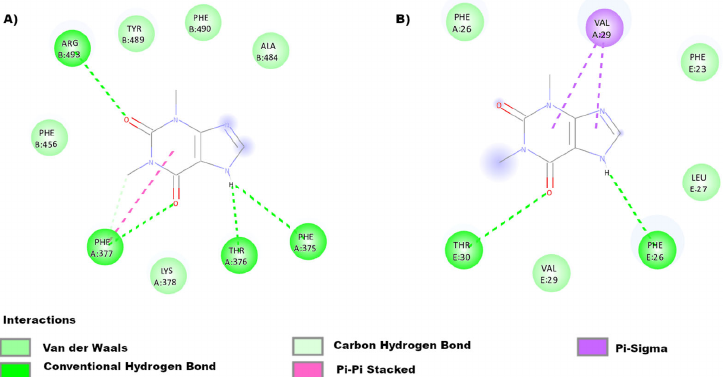
Figure 4. Molecular docking between theophylline and SARS ‐ CoV ‐ 2 proteins (spike and protein E). In both couplings, we observe Van der Waals forces. ( A ) The interactions between theophylline